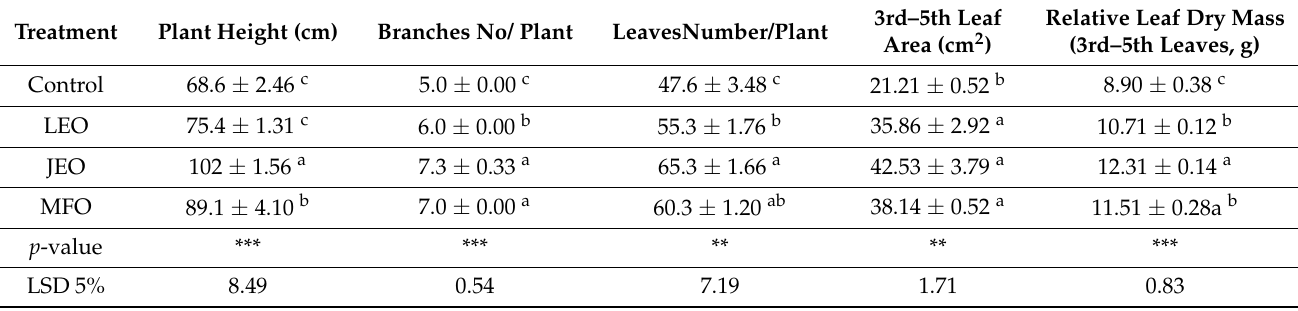
Table 2. The effect of foliar application with jasmine and lavender essential oils or mustard fixed oil on eggplant growth under TSSM natural infestation in a controlled